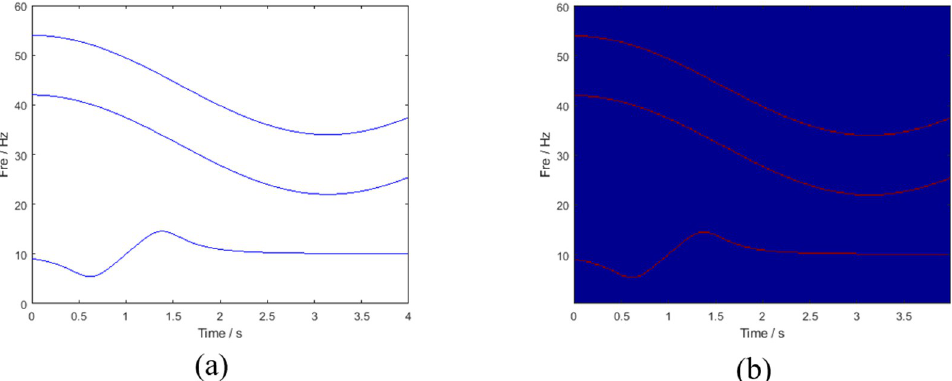
Fig 4. (a) Ideal instantaneous frequency and (b) ideal